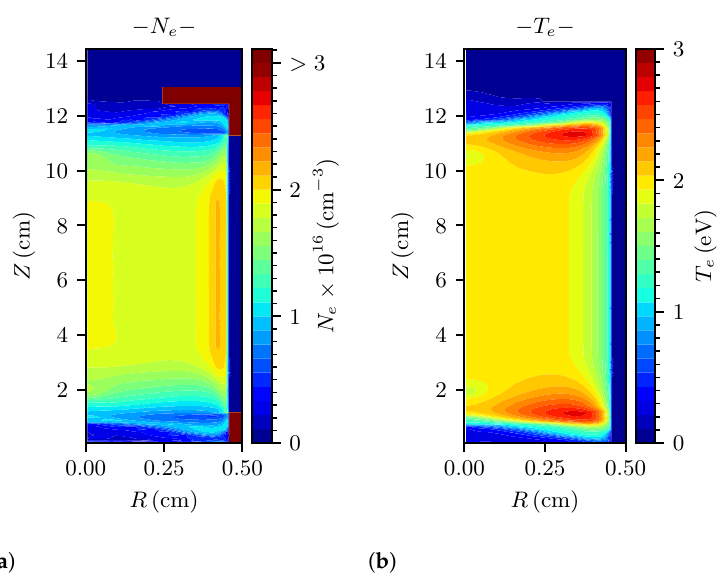
Figure 6. Spatial distributions of ( a ) electron density N e and ( b ) electron temperature T e inside the tube at t = 5.6 µ s. Electrodes are indicated by dark red color ( N e > 3 × 10 16 cm − 3 ) in ( a ). Please note, that the scales for radial and longitudinal coordinates are different.